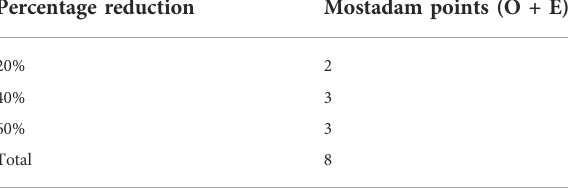
TABLE 1 Points for reducing water (Mostadam Manual,